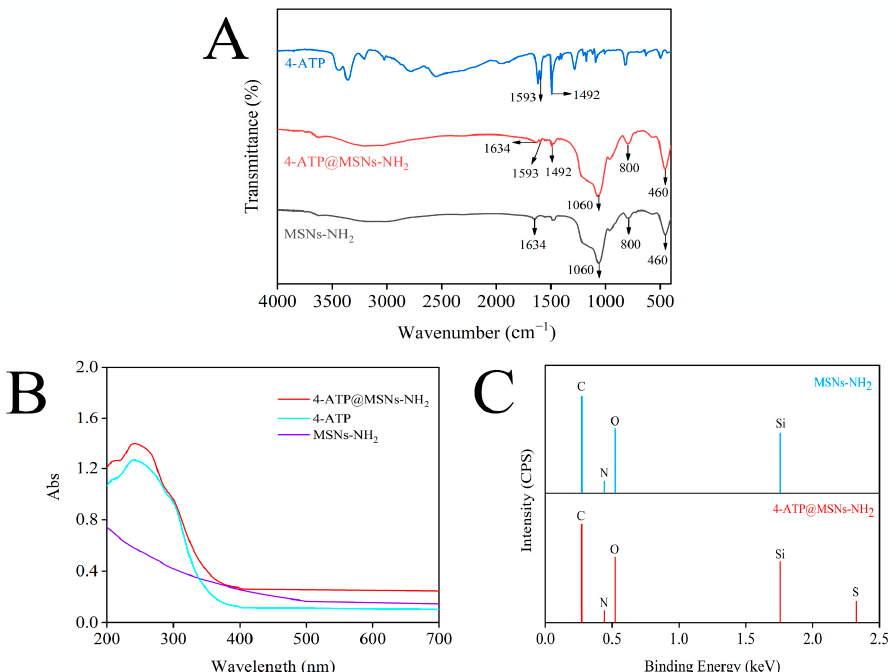
Figure 3. The FTIR ( A ) and UV–Vis absorption spectrum ( B ) of MSNs-NH 2 , 4-ATP, and 4-